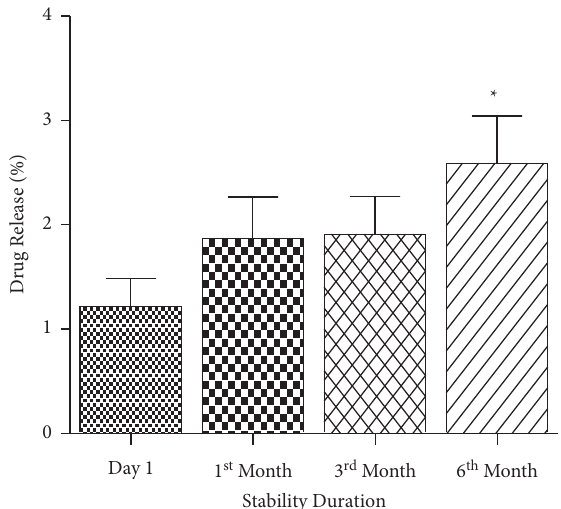
Figure 6: SRP release in acidic media (0.1N HCl): ∗ P < 0 . 05 compared to day 1.